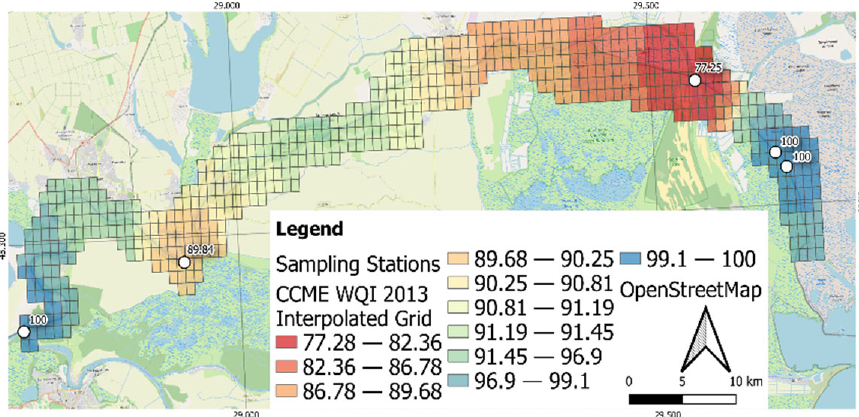
Figure 4. CCME WQI trends in 2013 on the Chilia branch.